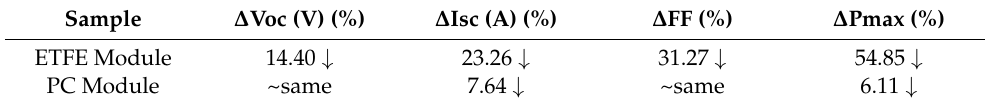
Table 2. Percentage decrease in the electrical parameters after the UV test of the PV module. Sample